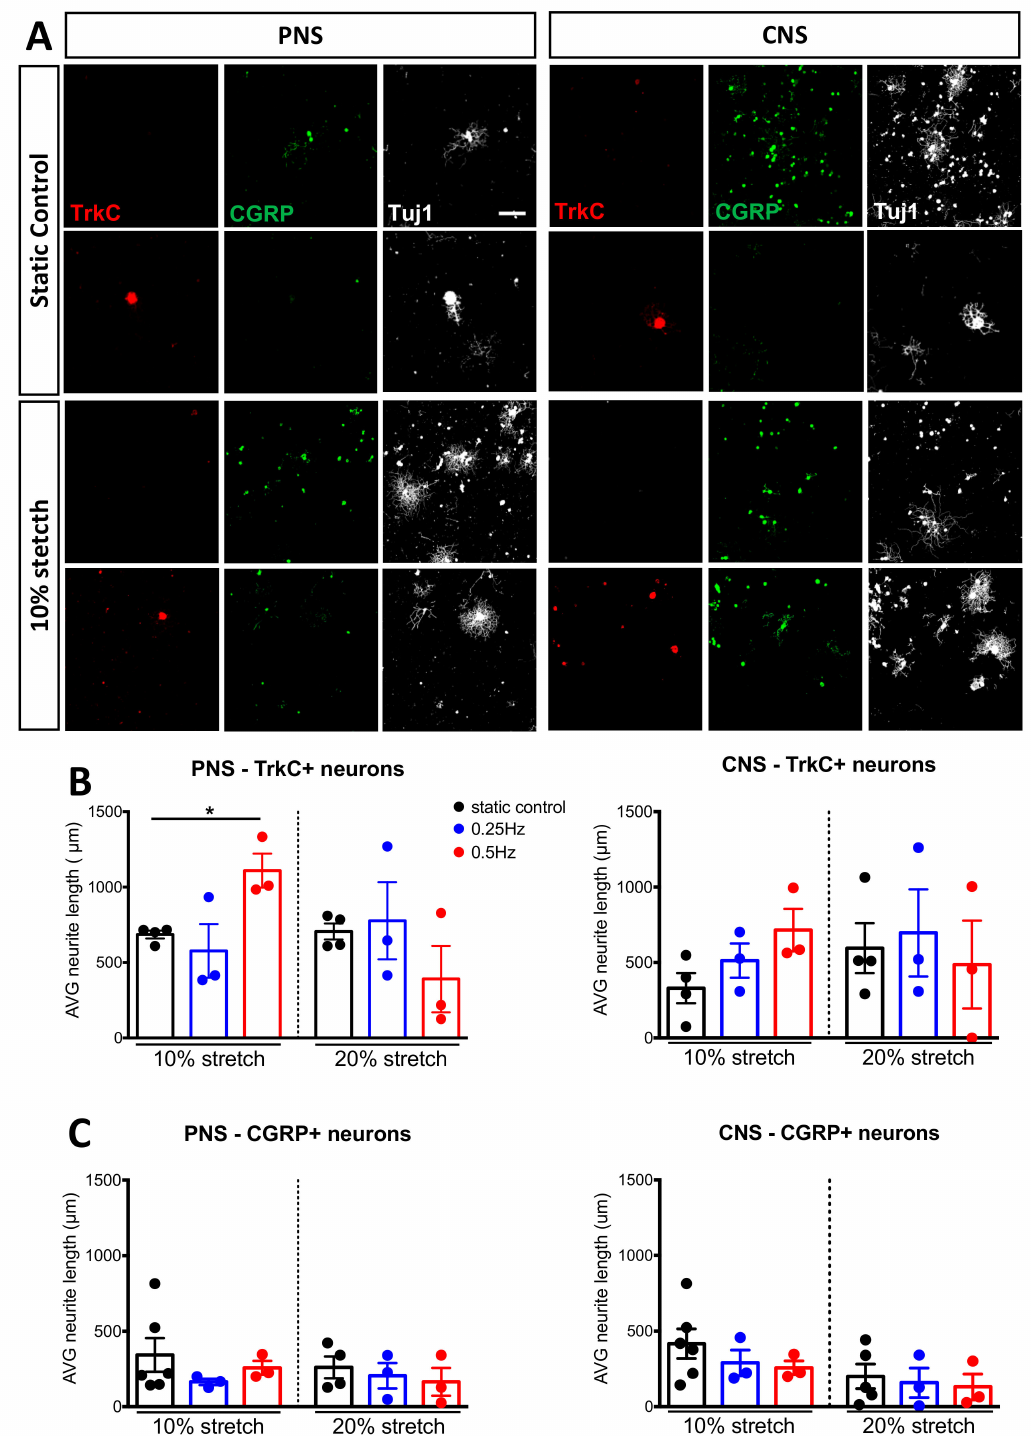
Figure 7. TrkC+ but not CGRP+ DRG neurons respond after mechanical stretch. ( A ) Immunocytochemical analysis of DRG stained either for TrkC (green) or CGRP (red) after either no stretch or mechanical stretch (10% 0.5 Hz). Scale bar, 200 µ m ( B ) Neurite length analysis of TrkC+ DRG upon mechanical stretch with an amplitude of either 10% or 20% and a frequency of 0.25 Hz or 0.5 Hz. ( C ) Neurite length analysis of CGRP+ DRG upon mechanical stretch with an amplitude of either 10% or 20% and a frequency of 0.25 Hz or 0.5 Hz. Two-way ANOVA, with post-hoc Sidak’s multiple comparison test, mean ± SEM, * p <